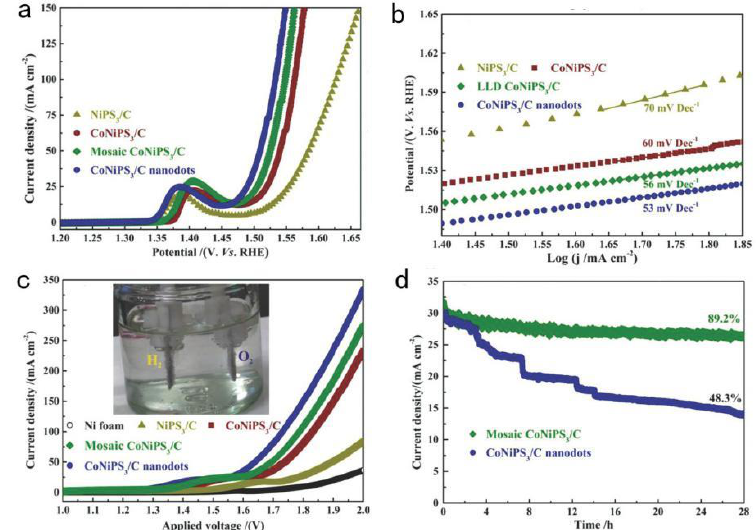
Figure 15. ( a ) ORR LSV curves of N-doped graphene (NGNs), Fe 3 C / Fe 2 O 3 @NGNs, and commercial Pt / C electrocatalysts in O 2 -saturated 0.1 M KOH condition. ( b ) The ORR Tafel plots of NGNs, Fe 3 C / Fe 2 O 3 @NGNs, and Pt / C electrocatalysts obtained by fitting LSV curves using linear equation at 1600 rpm. ( c ) OER LSV curves of Fe 3 C / Fe 2 O 3 @NGNs, NGNs and IrO 2 in N 2 -saturated 0.1 M KOH. ( d ) The OER Tafel plots of Fe 3 C/Fe 2 O 3 @NGNs, NGNs and IrO 2 . Reproduced with permission from [43]. Copyright 2019 Carbon .